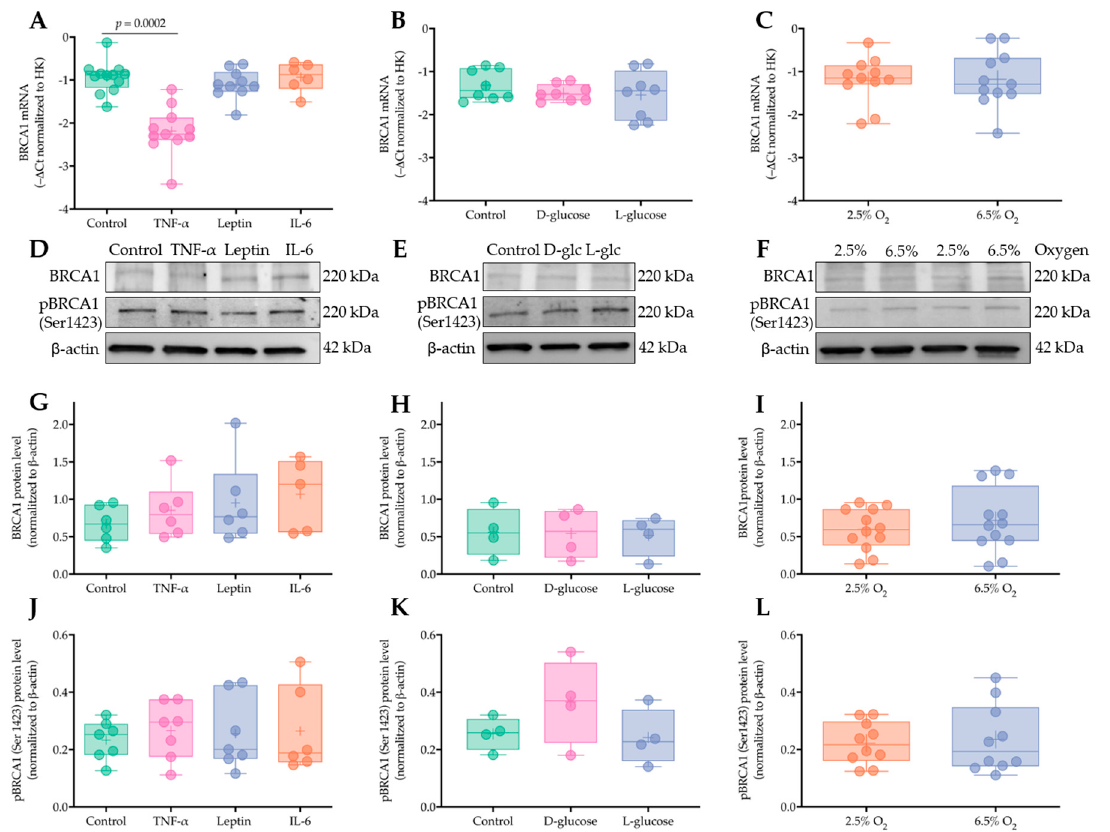
Figure 6. BRCA1 is not regulated by short term exposure to obesity-associated